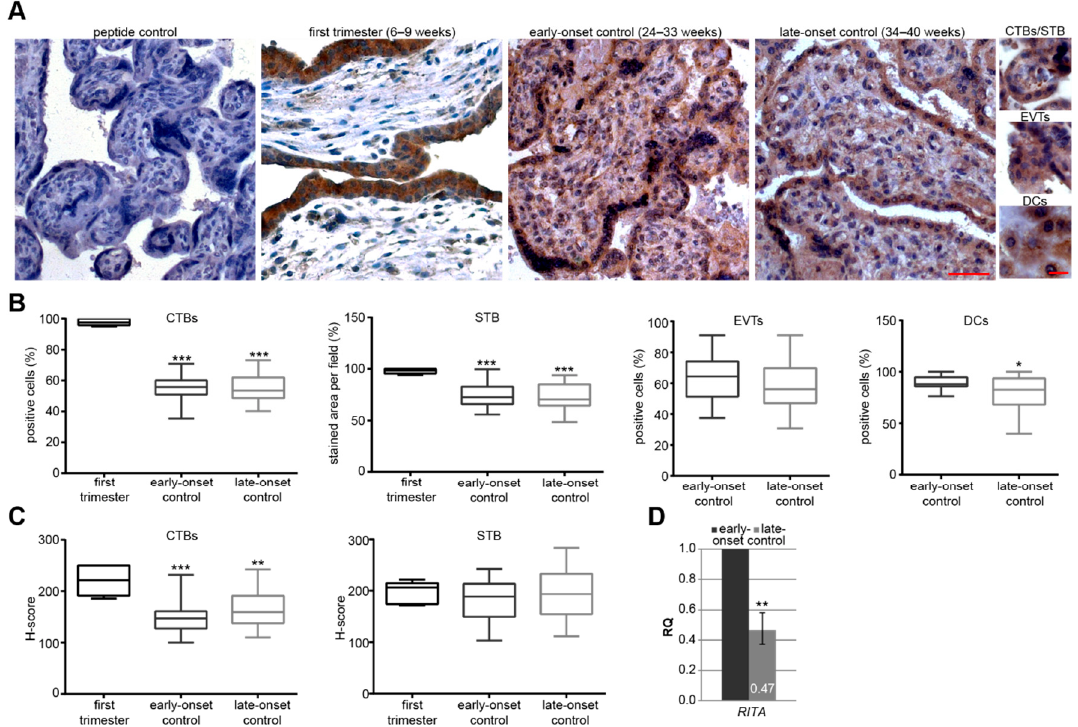
Figure 1. R BP-J (recombination signal binding protein J)- i nteracting and t ubulin- a ssociated protein (RITA) is expressed in trophoblastic cells of placental tissue and its gene expression decreases at late stages of gestation. ( A ) Paraffin-embedded tissue sections were immunohistochemically stained with a specific RITA antibody (brown) and counterstained with hematoxylin (blue). RITA antibody neutralized with its corresponding peptide (peptide control) was used as negative control. Scale of images: 50 μ m, scale of small images: 20 μ m. CTBs, cytotrophoblasts; STB, syncytiotrophoblast; EVTs, extravillous trophoblasts; DCs, decidual cells. ( B ) Quantification of RITA positive cells in first trimester placental sections (6–9 weeks, n = 6), early-onset control (24–33 weeks; n = 20), and late-onset control samples (34–40 weeks; n = 21). The results are presented as box and whisker plots with minimum and maximum variations. Student’s t -test, * p < 0.05, ** p < 0.01, *** p < 0.001. ( C ) Semi-quantitative